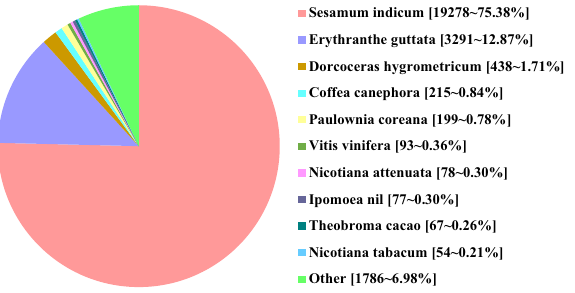
Figure 2. The Homologous species distribution of P. catalpifolia HQ transcripts. Figure was made by Microsoft Office Excel 2013 software.